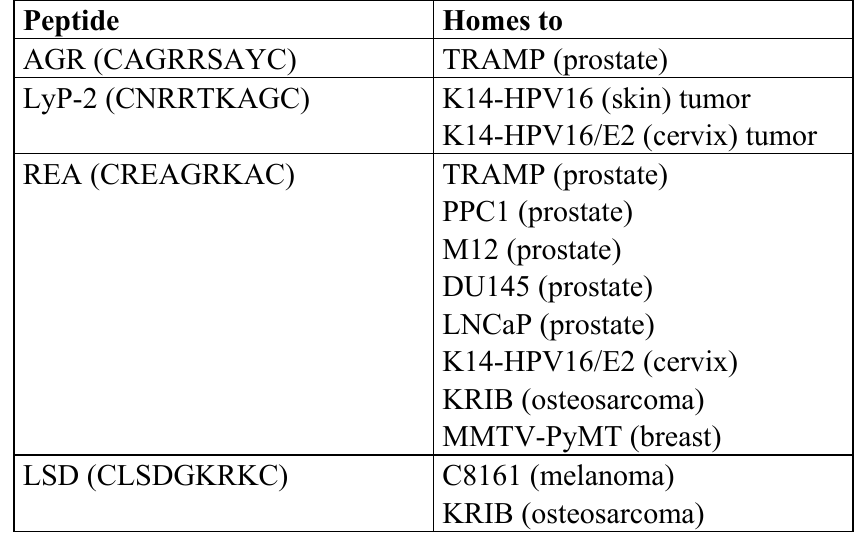
Table 1. Examples of some homing peptides and their cancer target